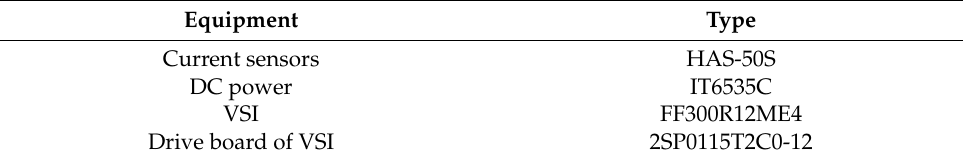
Figure 12. Experimental prototype. Table 2. Experimental